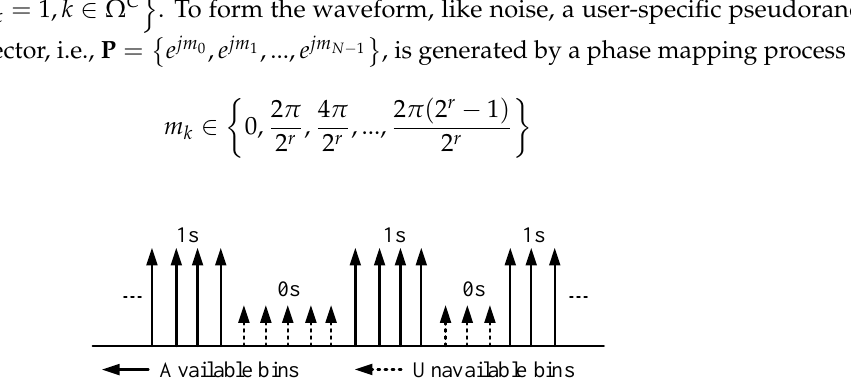
Figure 1. An example of the spectrum sensing result for vector A.